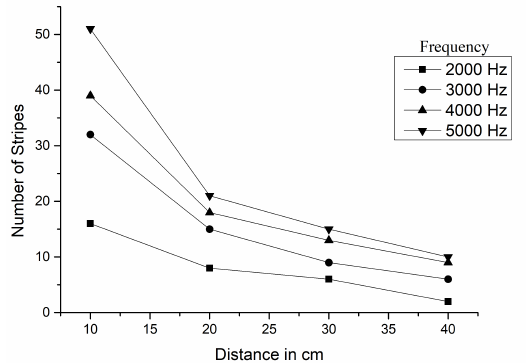
Figure 10. OOK Modulation Distance vs. Detectable Stripes for various frequencies.